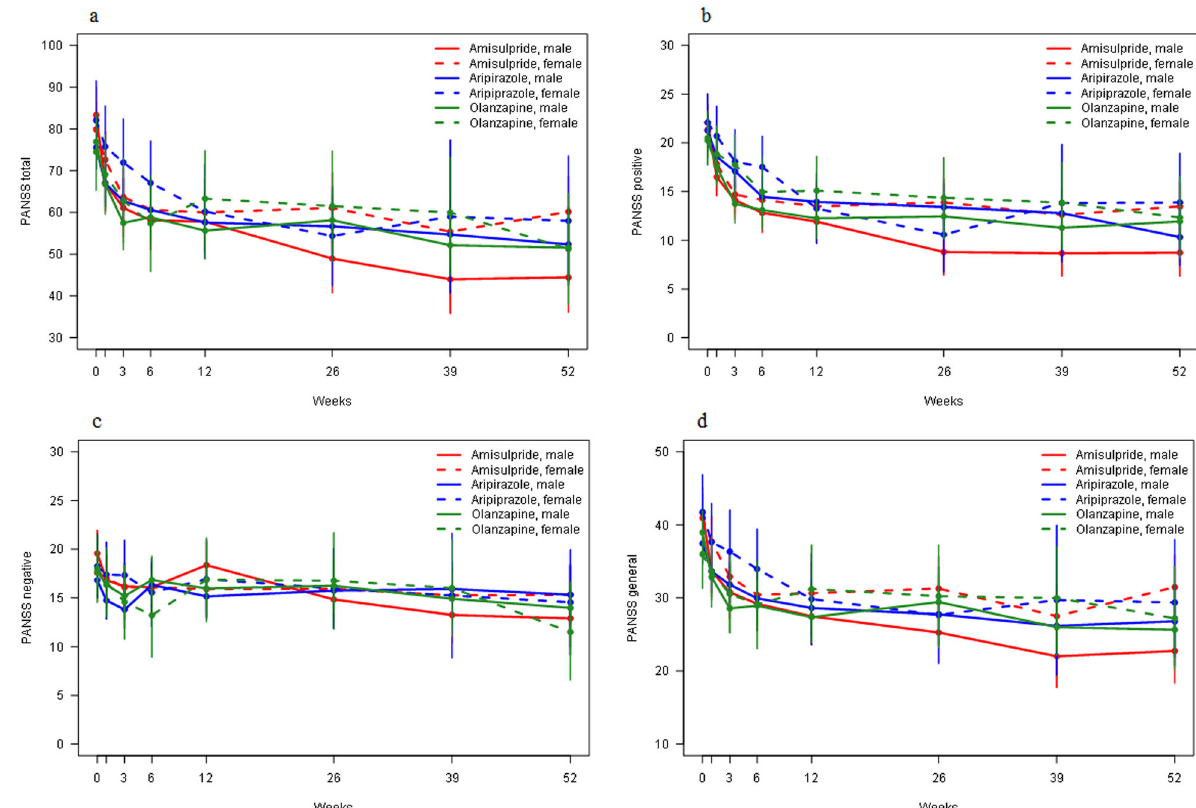
Fig. 1 PANSS score reduction per timepoint. This fi gure shows the PANSS score reduction for PANSS total ( a ), PANSS positive ( b ), PANSS negative ( c ), and PANSS general ( d ) at different timepoints (0, 1, 3, 6, 12, 26, 39, and 52 weeks). All antipsychotic medications were analyzed for men and women separately. Sample sizes were as follows: amisulpride male group n = 25; amisulpride female group n = 27; aripiprazole male group n = 39; aripiprazole female group n = 12; olanzapine male group n = 29; olanzapine female group n = 12. The analysis is based on